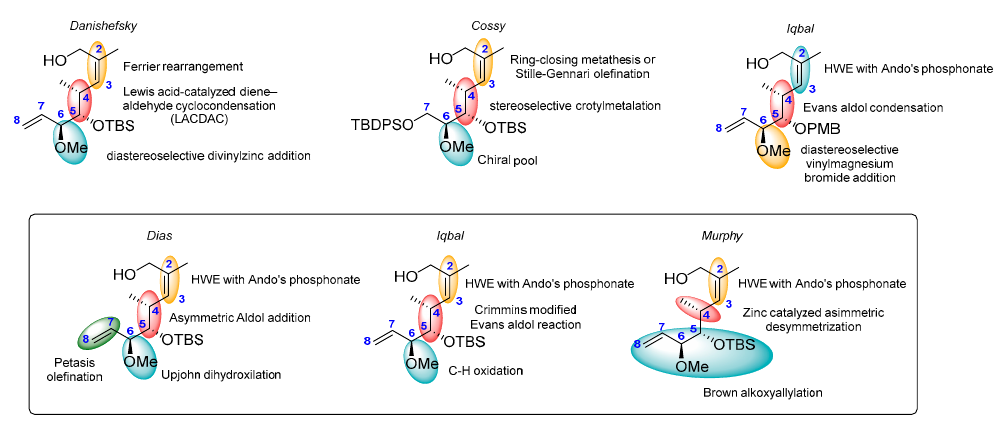
Figure 3. Synthetic strategies for the preparation of advanced intermediate 8 . Table 1. Synthetic key aspects for the preparation of advanced precursor 8 .